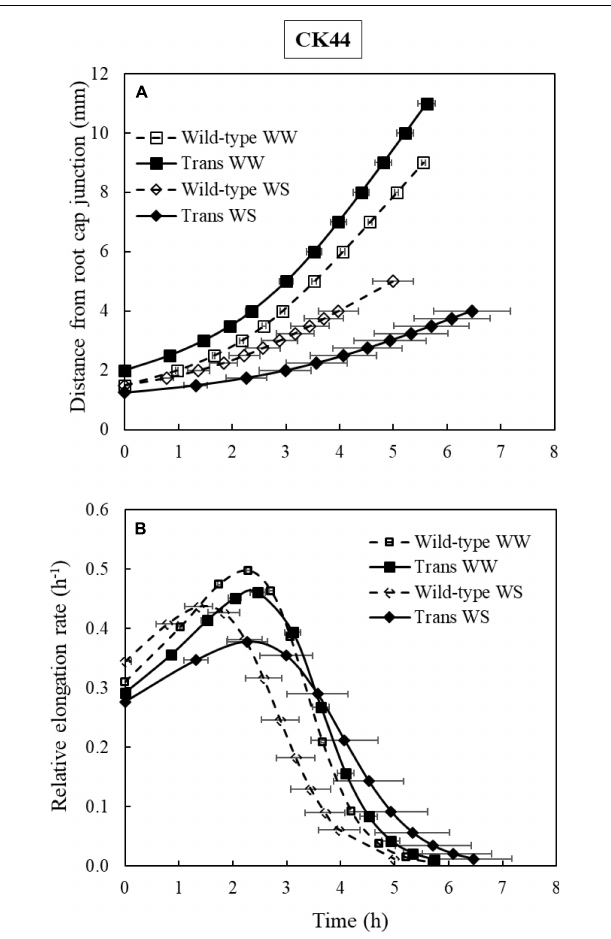
FIGURE 6 | Growth trajectories (A) and temporal relative elongation rate profiles (B) of the primary root of CK44 oxalate oxidase transgenic (Trans) and wild-type lines growing under well-watered (WW) or water-stressed (WS; –1.6 MPa) conditions. Growth trajectories were used to determine the times required for cells to move from the distal end of the meristem to more basal locations, and were obtained by plotting position versus the integrated local displacement time. The relative elongation rate corresponding to a particular position ( Figures 5E,F ) was then plotted against the integrated displacement time to obtain the temporal relative elongation rate profiles (B) . The total residence times of cells within the growth zone were not significantly different between the transgenic and wild-type lines in either well-watered or water-stressed comparisons ( t -test; P > 0.1).